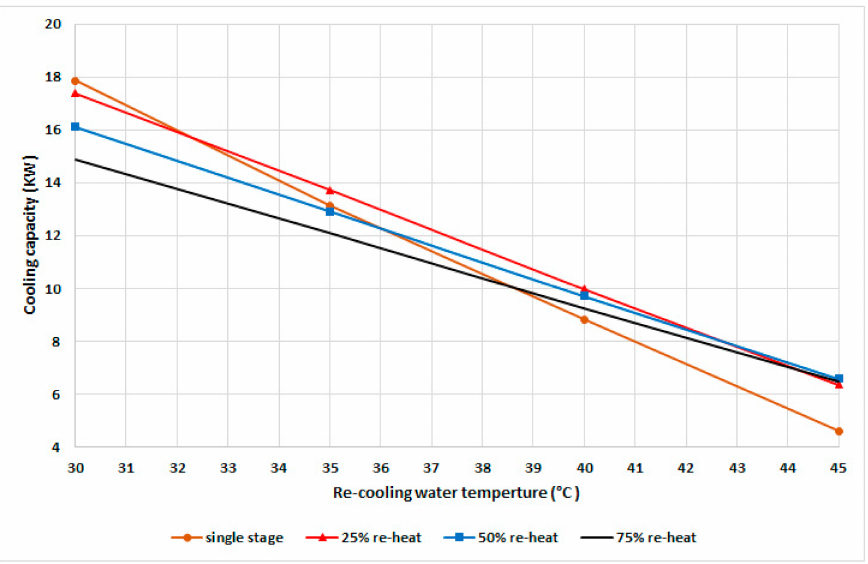
Figure 5. Cooling capacity at various recooling-water temperatures and